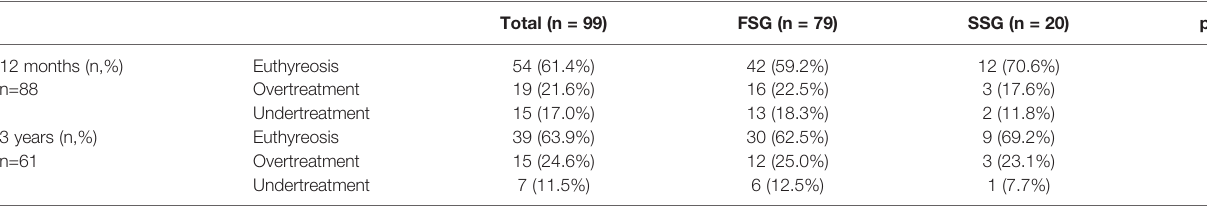
FSG, fi rst screening group; SSG, second screening